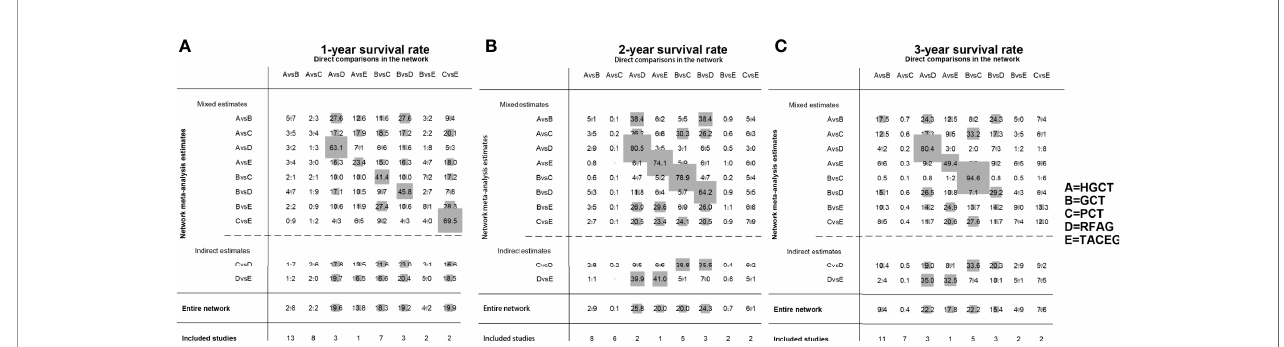
FIGURE 3 | Contribution plot of the included studies. The columns refer to the direct comparisons and the rows refer to all possible pairwise comparisons. (A) Contribution plot for 1- year survival rate. (B) Contribution plot for 2- year survival rate. (C) Contribution plot for 3- year survival rate. HGCT, hepatectomy and gastrectomy plus chemotherapy; GCT, gastrectomy plus chemotherapy; PCT, palliative chemotherapy; RFAG, radiofrequency ablation and gastrectomy plus chemotherapy; TACEG, transarterial chemoembolization and gastrectomy plus chemotherapy.